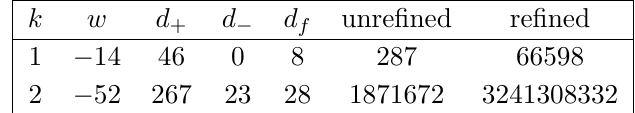
Table 11 . Numbers of possible terms in the numerator of the elliptic genus of k strings for G = D in terms of elements of the ring J (cid:3) ; (cid:3) ( d 4 ) of Weyl invariant Jacobi forms both in the unre(cid:12)ned and re(cid:12)ned case. The modular weight w and indices d (cid:6) ; d f of the numerator are also listed.